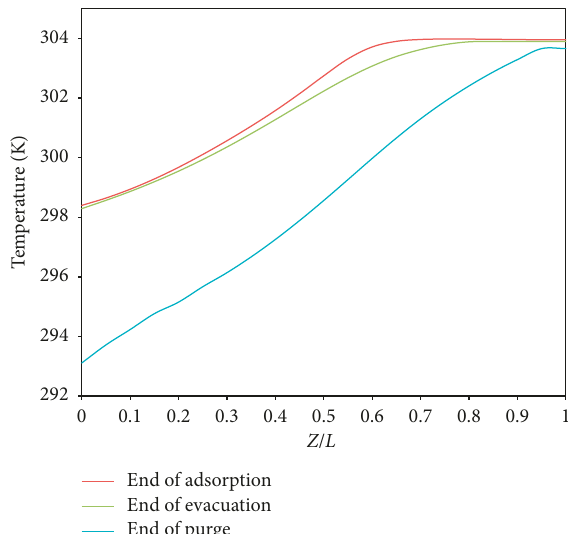
Figure 11: Axial Temperature profiles at the end of different steps of the cycle at steady state.